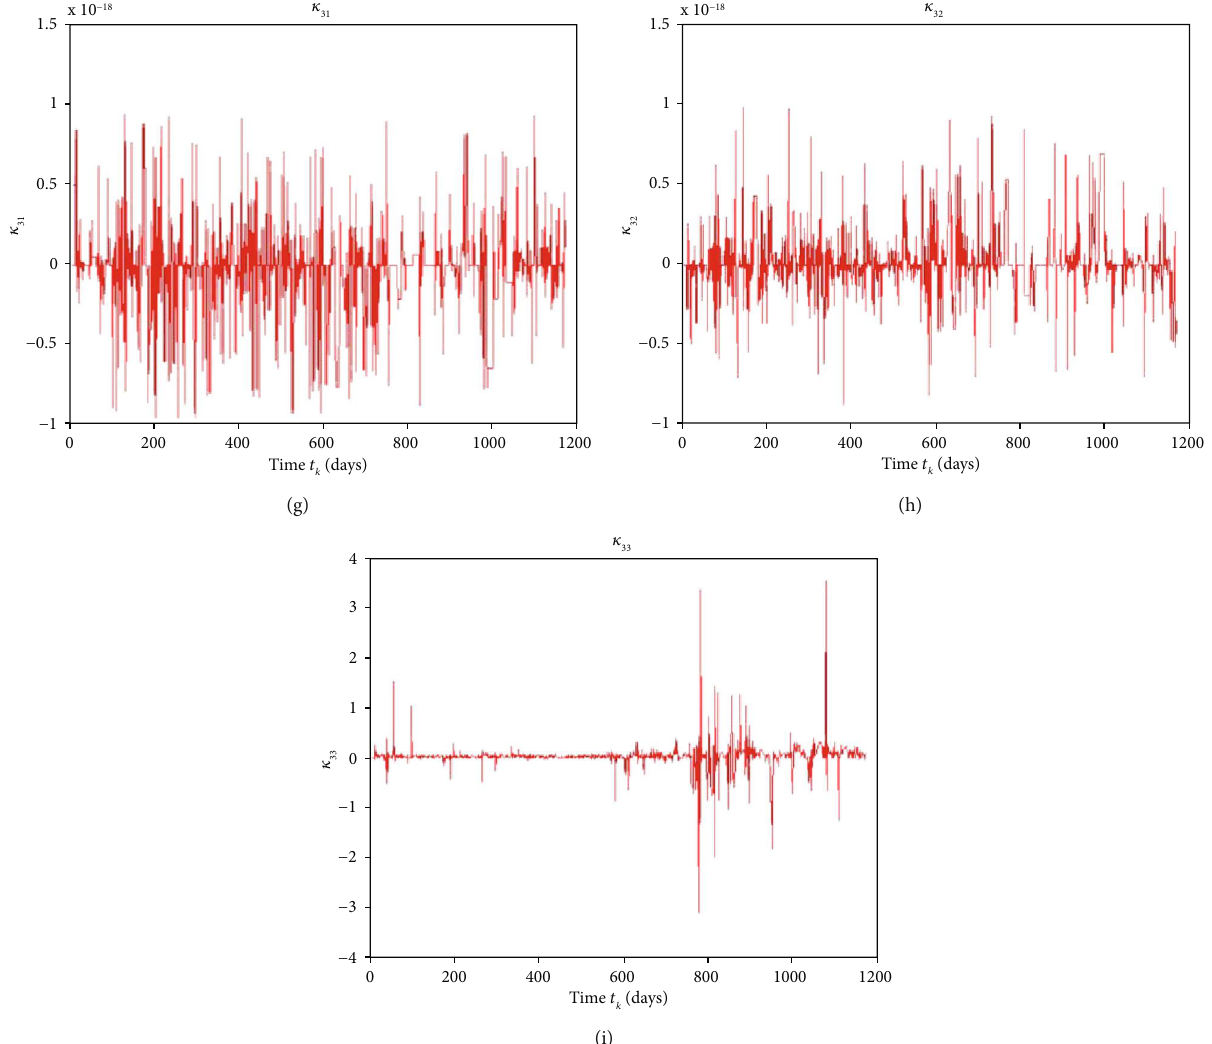
Figure 2: The graph of interaction coe ffi cients κ and κ